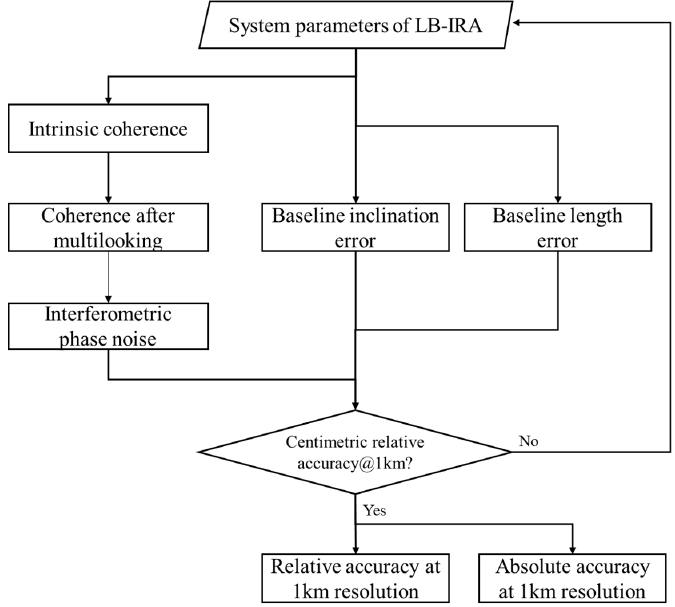
Figure 14. Flowchart of the methodology for parameters selection.